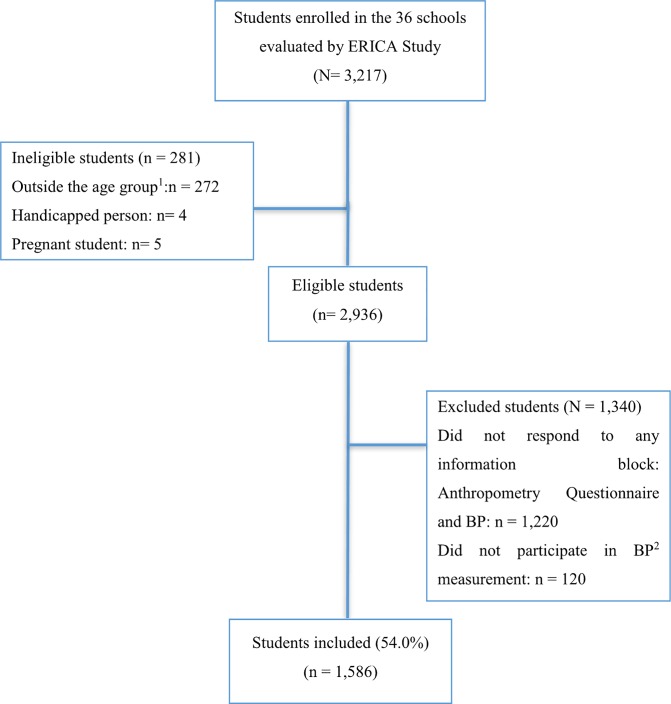
Flow chart for selection of study participants, ERICA Study, Goiânia, Goiás, Central-West region of Brazil, 2013–2014 Legend: 1Children under 12 and over 17 years of age; 2blood pressure.